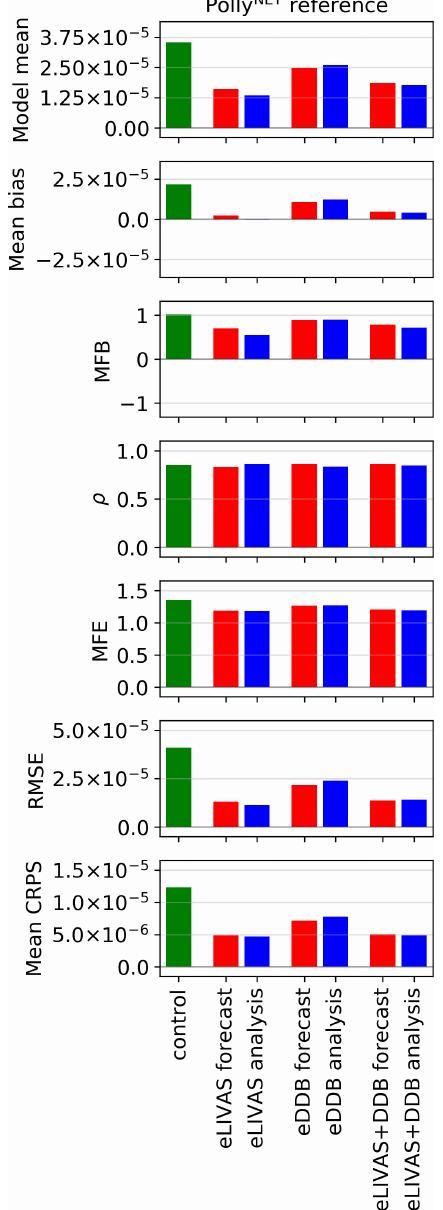
Figure 8. Verification scores against ground-based PollyNET lidar dust extinction coefficients from the CyCARE and Pre-TECT cam- paigns. Panels of model mean, mean bias, RMSE, and mean CRPS have units of m − 1